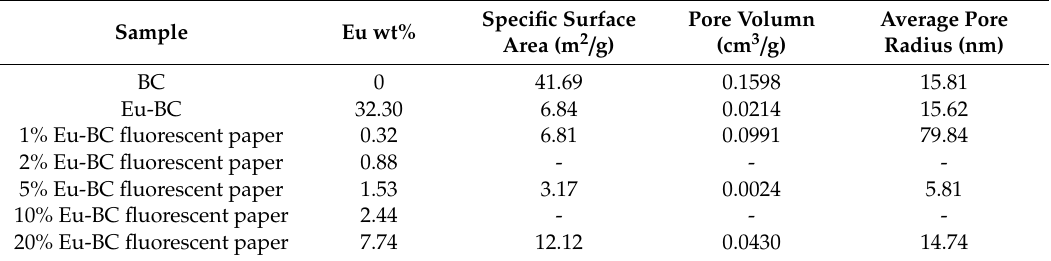
Figure 3. Photographs of 20% BC paper (without Eu) and 20% Eu-BC fluorescent paper ( a ) under visible light and ( b ) under ultraviolet light. Table 1. Eu contents and BET parameters of BC, Eu-BC, and fluorescent paper sheets with different Eu-BC contents.